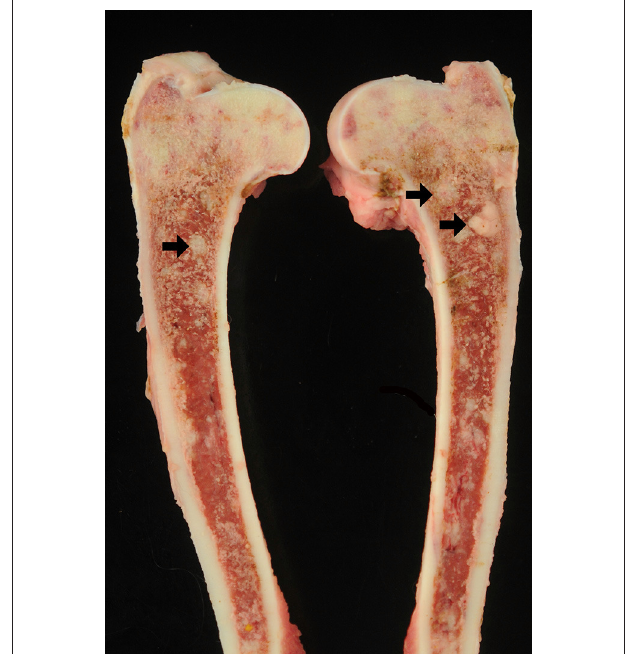
FIGURE 1 | Photographs from gross postmortem examination of a 2.5-year-old, female spayed, Australian Shepherd dog that had a 2-month history of tetraparesis, progressive lethargy, and severe pain. The bone marrow and trabecular bone from both femurs were replaced and expanded by multifocal to coalescing pale tan, soft, nodules ranging from pinpoint to 2.0cm in diameter